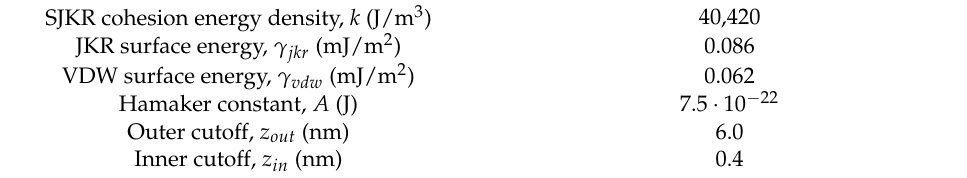
Table 4. Cohesion parameters for SJKR, JKR and VDW models by considering Bo = 500.